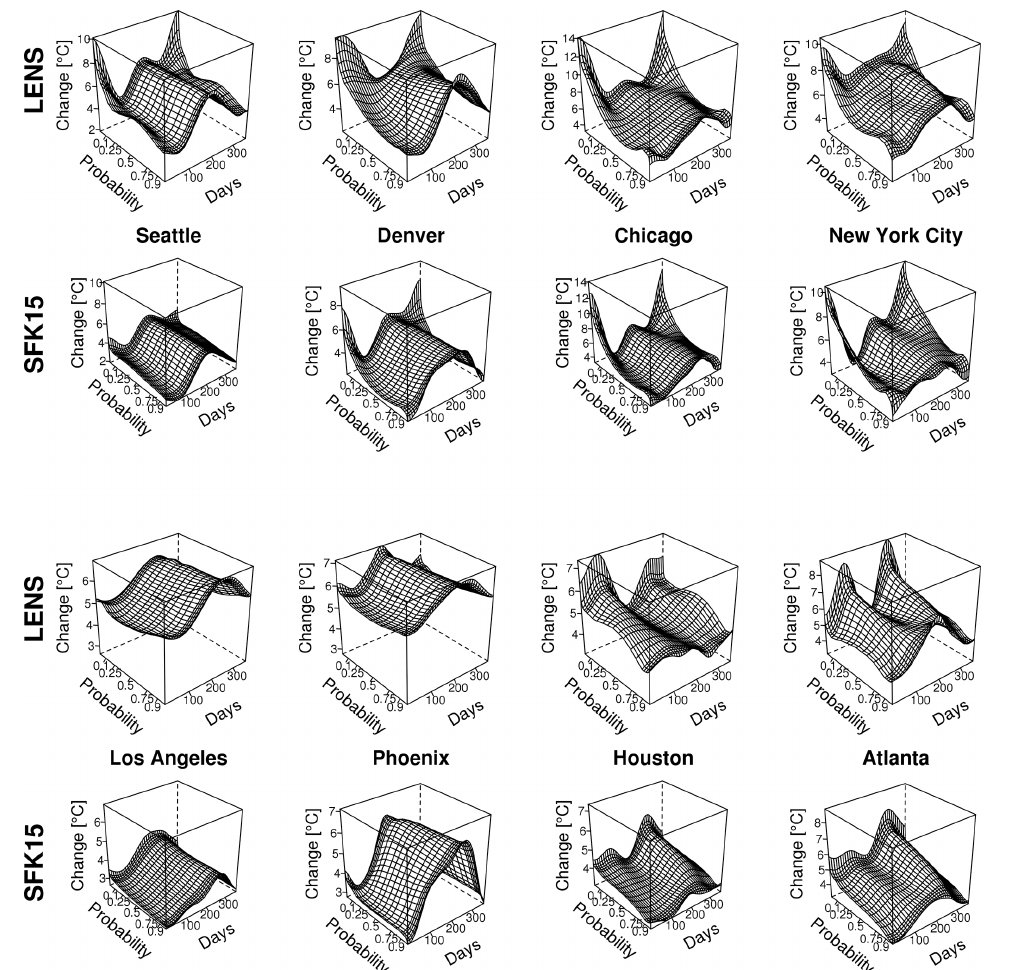
Figure 4. Quantile maps of temperature changes between 1989 and 2099 for multiple cities extracted from the SFK15 ensemble on the first and third rows and the LENS ensemble on the second and fourth rows. Temperature change is shown as a function of seasonality (days of the year) and non-exceedance probability of the temperature estimate. Note that z axes are consistent for each location but differ between